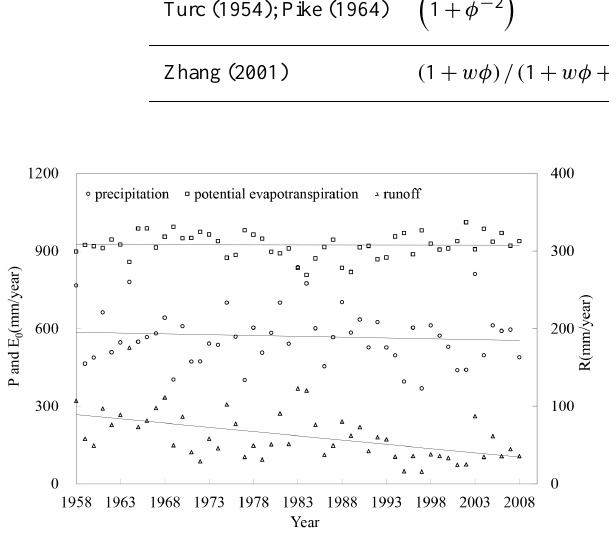
Figure 2. Time series of annual precipitation, annual potential evap- otranspiration and annual runoff in the Wei River basin from 1958 to 2008.